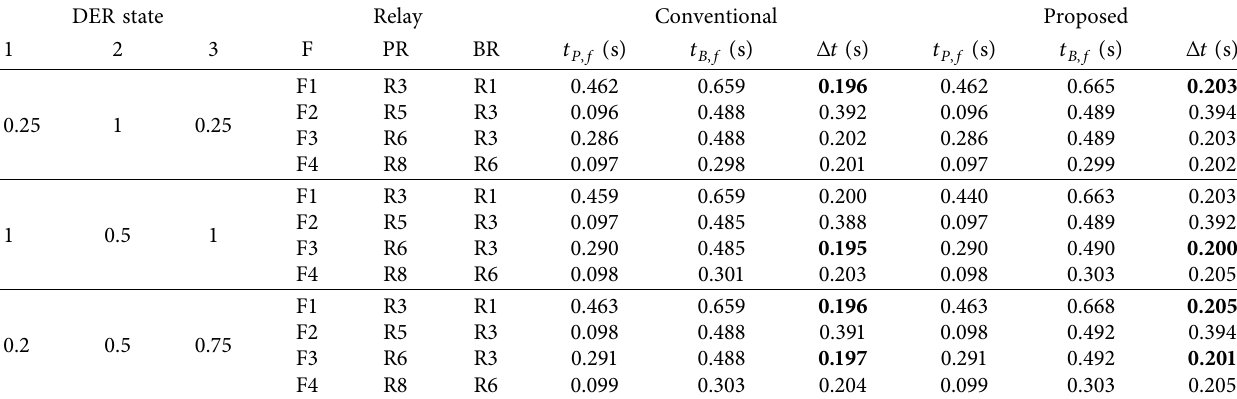
Table 5: Operating time for the proposed adaptive and conventional protection approach for variation in DERs powers. DER